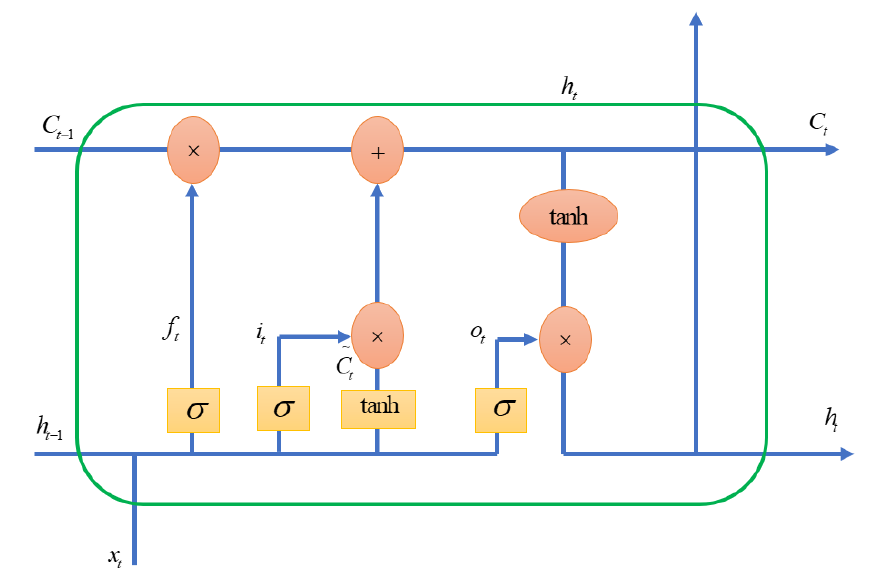
Figure 2. Representation of LSTM cell.